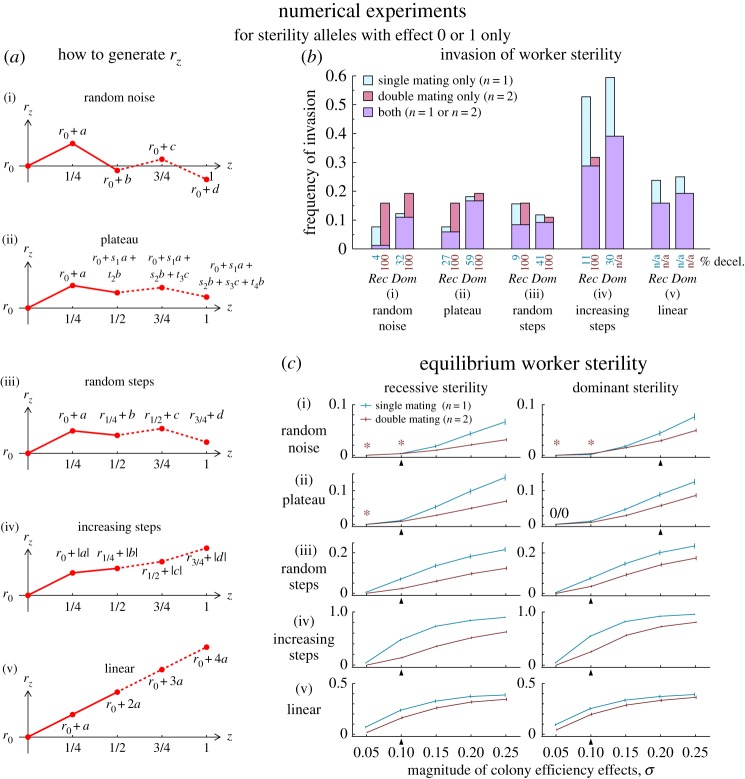
Here, we compare the evolution of worker sterility under single (n=1) versus double mating (n=2) by revisiting the numerical experiments of Olejarz et al. [19]. (a) There are many possible ways to construct the colony efficiency function rz based on picking random numbers from a normal distribution. Five alternatives are shown here, including the two procedures used by Olejarz et al. (‘Random noise’, their Procedure 1, and ‘Plateau’, their Procedure 2; see Methods). For testing whether sterility invades, only two points are needed (solid lines), but this can be extended to four points (dashed lines) for measuring sterility at equilibrium. (b) We record the frequency of invasion of a full-sterility allele under single versus double mating, running 10 million experiments for each scenario. Percentages beneath the bar chart show that an initially decelerating rz is required for sterility to invade under double mating only (see Methods). (c) We record the average worker sterility at equilibrium over 5000 experiments for each scenario. Except when rz is constructed using the ‘random noise’ or ‘plateau’ procedure for a small magnitude of efficiency effects (asterisks), single mating tends to promote average worker sterility at equilibrium relative to double mating (the 0/0 denotes no worker sterility under either single or double mating). This can happen even if sterility is more likely to invade under double mating (for example, compare results of procedures (i)–(iii) in (b) versus (c)). Arrowheads beneath the x-axis show where parameters coincide with those used in (b). The ‘magnitude of colony efficiency effects’ is the standard deviation of normally distributed variates used for constructing rz. For (b) and (c), we assume pz=0.2+0.8z. See Methods for details.